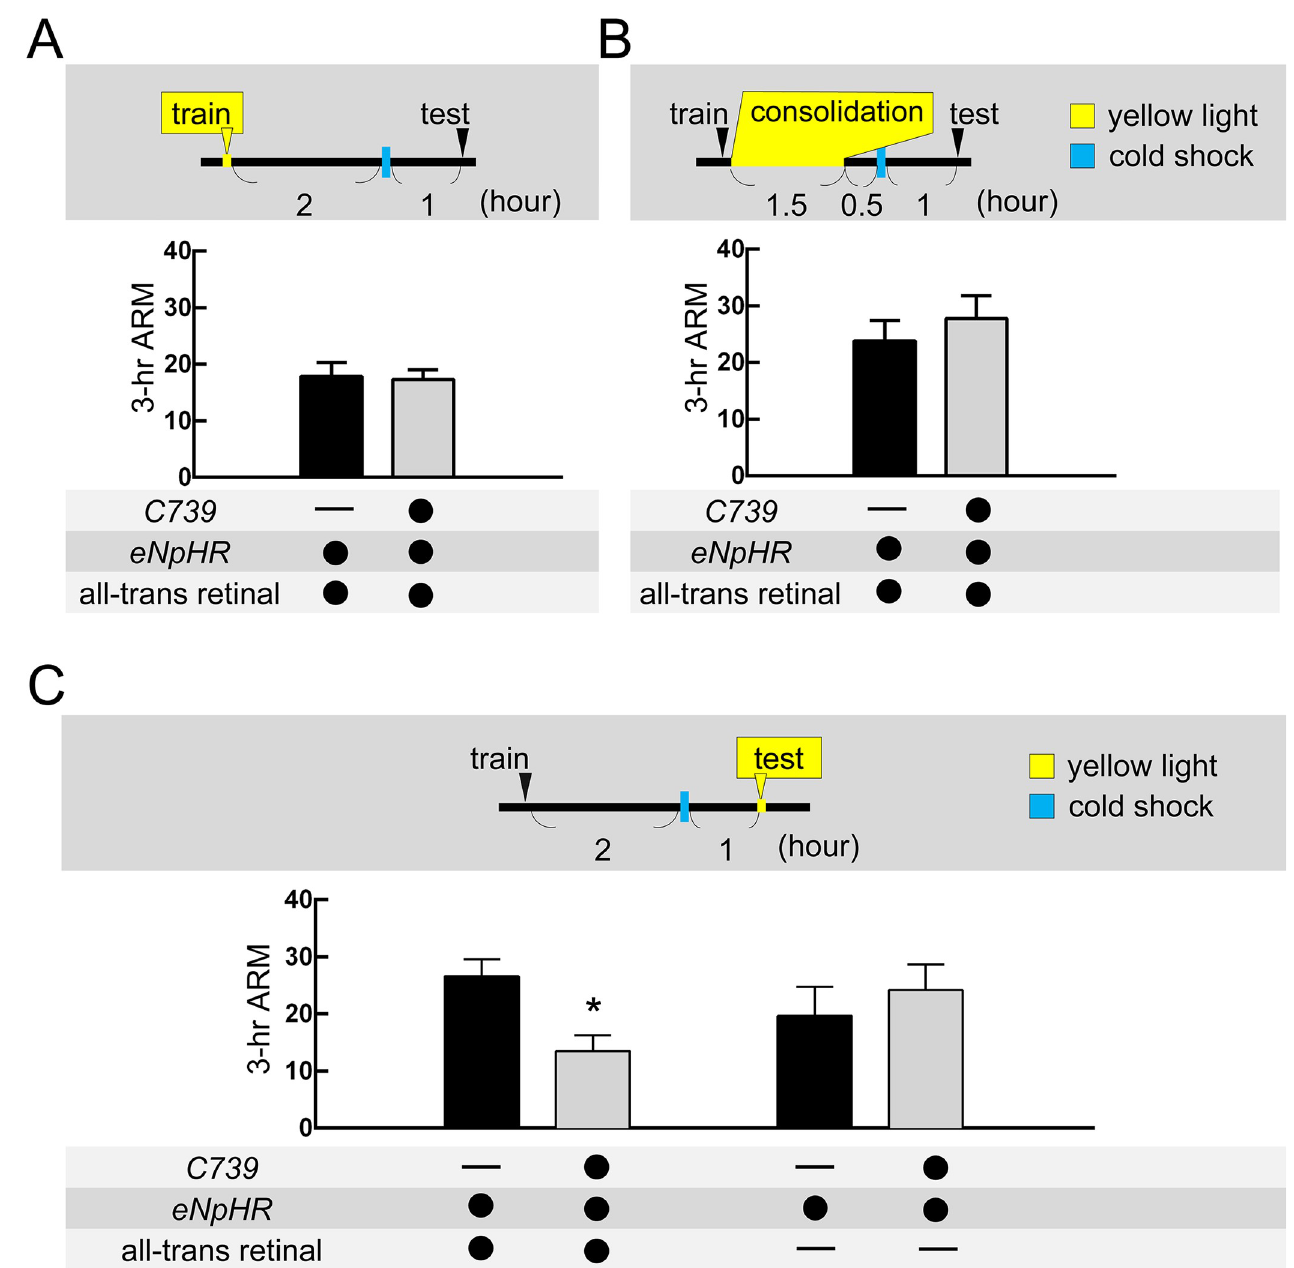
Fig 5. Hyperpolarization of αβ neurons during retrieval but not during acquisition or consolidation, impairs ARM. (A) eNpHR -mediated hyperpolarization of αβ neurons during memory acquisition (train) did not affect 3-hour ARM. Each value represents the mean ± SEM (n = 6; p > 0.05, t-test). (B) eNpHR -mediated hyperpolarization of αβ neurons during memory consolidation did not affect 3-hour ARM. Each value represents the mean ± SEM (n = 6–9; p > 0.05, t-test). (C) eNpHR -mediated hyperpolarization of αβ neurons during memory retrieval (test) impaired 3-hour ARM. Each value represents the mean ± SEM (n = 6–10). � , p < 0.05; t-test. The genotypes were as follows: (1) +/UAS-eNpHR-YFP; +/UAS-eNpHR-YFP , (2) C739-GAL4/UAS-eNpHR-YFP; +/UAS-eNpHR-YFP